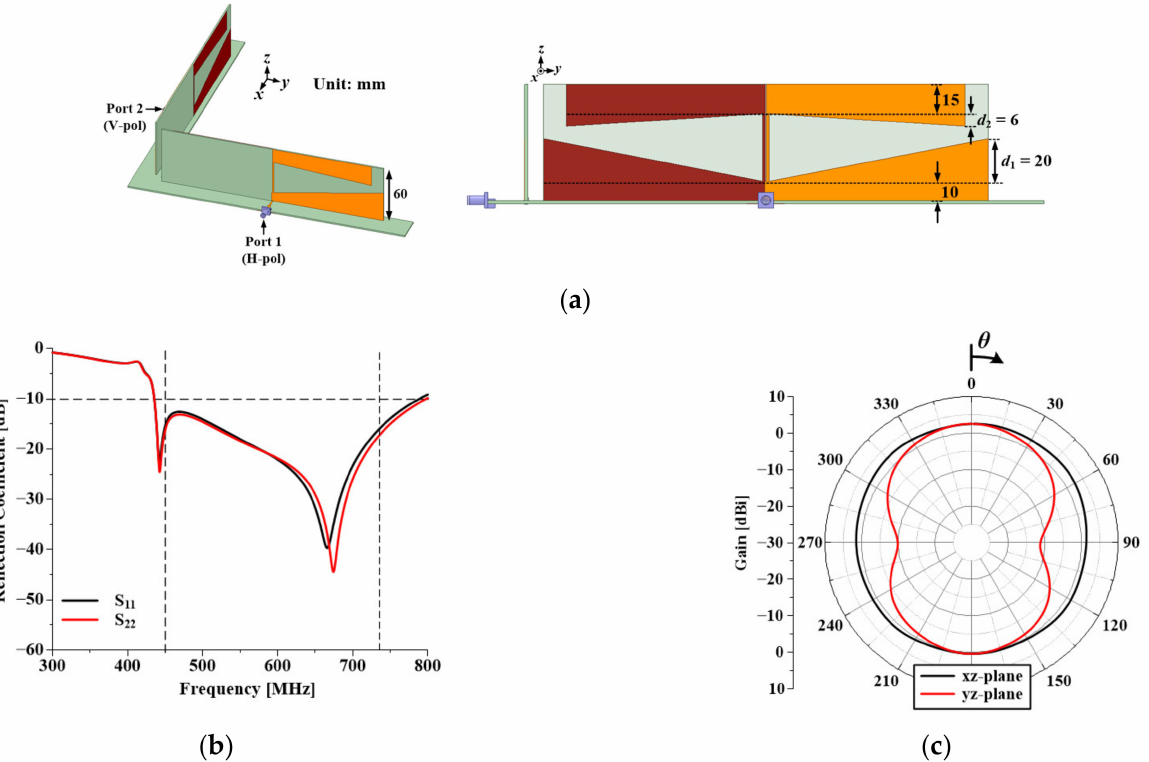
Figure 11. Optimized dual-polarization half bow-tie dipole antenna: ( a ) geometry of antenna, ( b ) simulated reflection coefficient performances, and ( c ) simulated radiation patterns at 580 MHz when Port 1 is